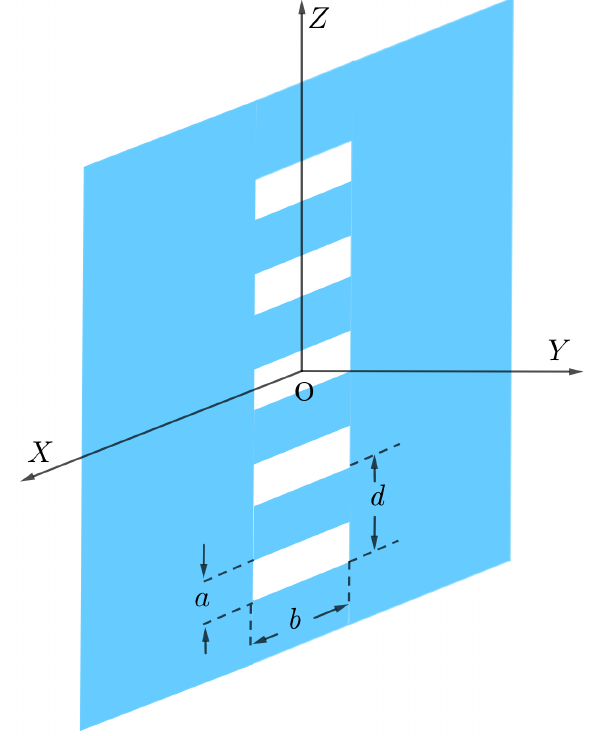
Figure 1. A diffraction grating with slits located in the x – z plane, a and b are the slit dimensions and d is the period of the